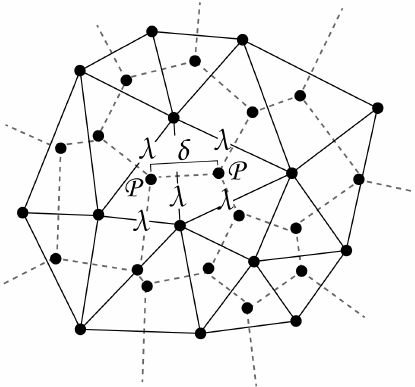
Fig.1: Illustrationofanunstructuredorthogonalgrid(solidlines).Anauxiliarygrid(dashedlines)composedofsegmentsthatjointhecentresofeach computationalcellisalsoshowntohighlightgeometricvariablesusedinthesection2.9 Fig. 1. Illustration of an unstructured orthogonal grid (solid lines). An auxiliary grid (dashed lines) composed of segments that join the centres of each computational cell is also shown to highlight geometric variables used in Sect.